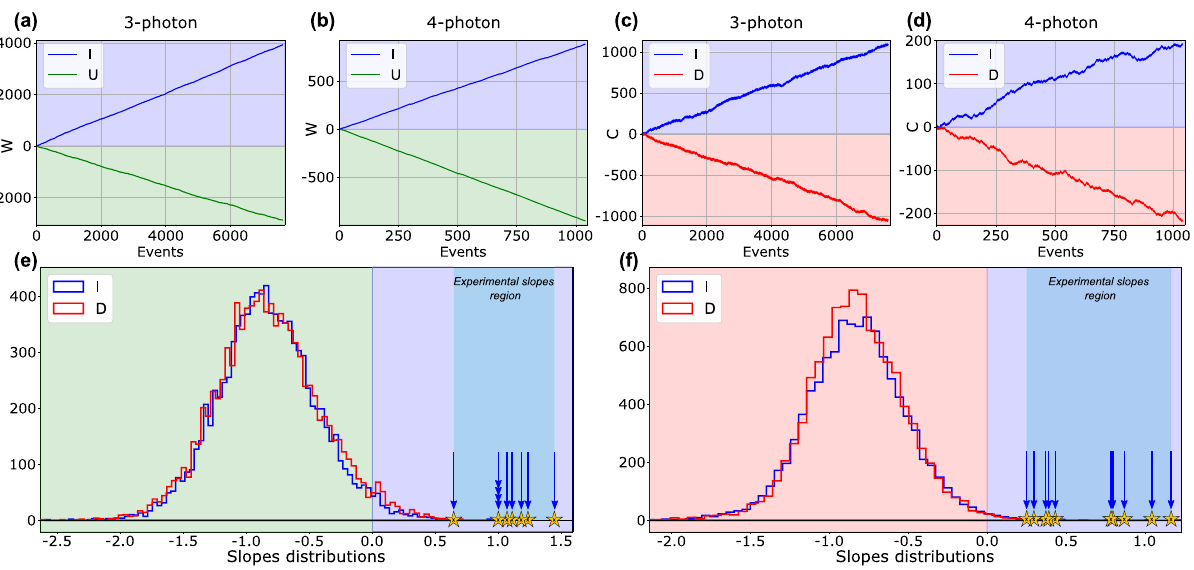
Fig. 4 Boson Sampling data. Validation of the 3-photon (blue points in ( a ) and 4-photon (blue points in ( b ) Boson Sampling experiments against the uniform sampler hypothesis (green point in a , b ). c , d Validation against the distinguishable photons sampler of 3- and 4-photon events. The test is applied using the same reconstructed sub-matrix in ( a ) and ( b ). The distinguishable samples (red points) were collected by adjusting the relative time delay between the input photons. e Histograms of simulated 3-photon slopes for counter W (normalized to the slopes of distinguishable particles data) in the case of validation against the uniform sampler using a random extracted U transformation, i.e. U matrices that do not match the actual operation implemented in the circuit. The obtained slopes of the 10 different 3-photon BS experiments are highlighted by the arrows (and by the corresponding stars). The experimental points were validated with the reconstructed sub-matrix retrieved from the two-photon reconstruction. All the experimental slopes values are in the positive range and far from the histograms average, thus showing the correct validation of the performed experiment. In ( f ), we performed the same analysis for the validation against the distinguishable photons